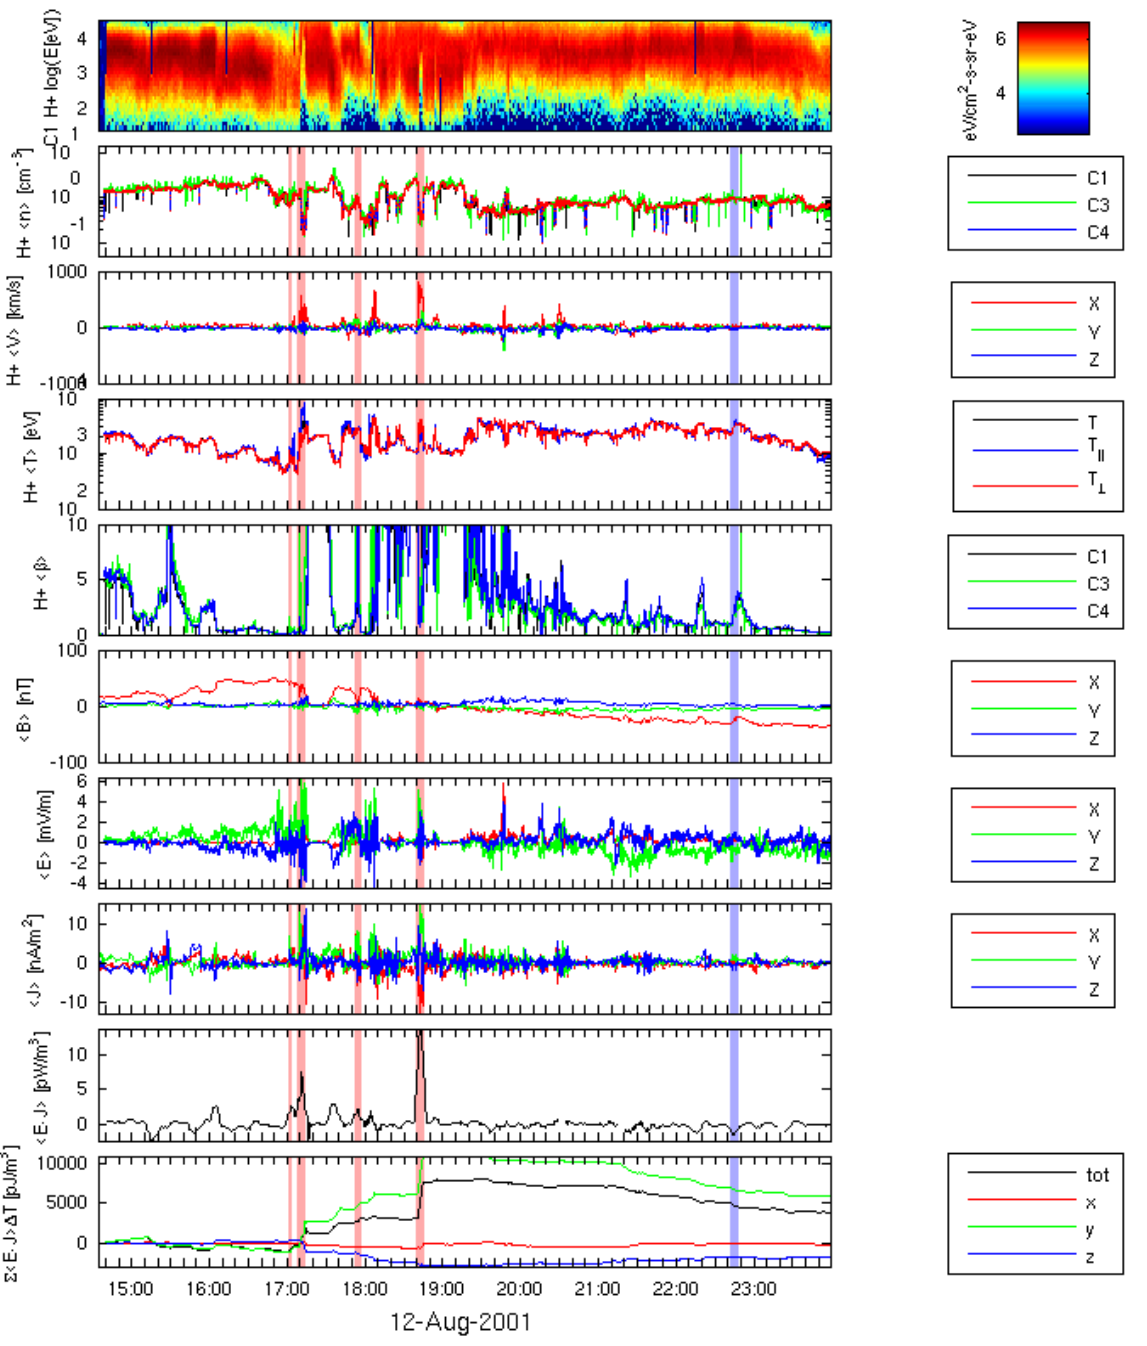
Fig. 2. ECRs automatically selected from a few hours of CODIF and FGM Cluster data. Highlighted regions correspond to CLRs (red) and CGRs (blue), respectively. The panels from top to bottom show: (a) CODIF proton energy spectrogram for C1. (b) Proton density obtained by C1, C3, and C4. (c) Plasma flow in GSE x , y , and z computed as an average over C1, C3, and C4. (d) Average, parallel and perpendicular proton temperature computed as an average over C1, C3, and C4. (e) The plasma beta obtained by C1, C3, and C4. (f) The magnetic field in GSE x , y , and z computed as an average over C1, C3, and C4. (g) The GSE x , y , and z components of the electric field average over C1, C3, and C4. (h) The GSE x , y , and z components of the current density average over C1, C3, and C4. (i) The power density E · J along the spacecraft orbit (the power density has been smoothed with a 5.5min running average to increase the visibility). (j) The time integral of the power density along the satellite path (no running average is used). Red, green and blue show contributions from the GSE E x J x , E y J y , and E z J z components. Black lines correspond to the full product E · J . To avoid any misinterpretations in the figure, note that we have kept the brackets around the quantities averaged over the spacecraft